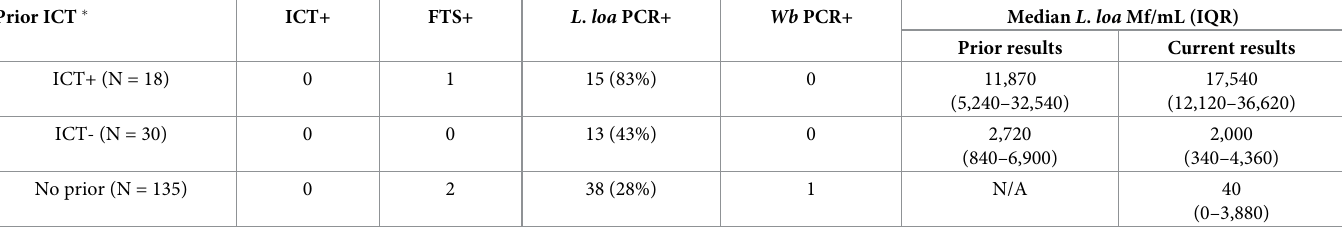
Table 1. Central Cameroon field study L . loa and W . bancrofti test results by prior ICT status.